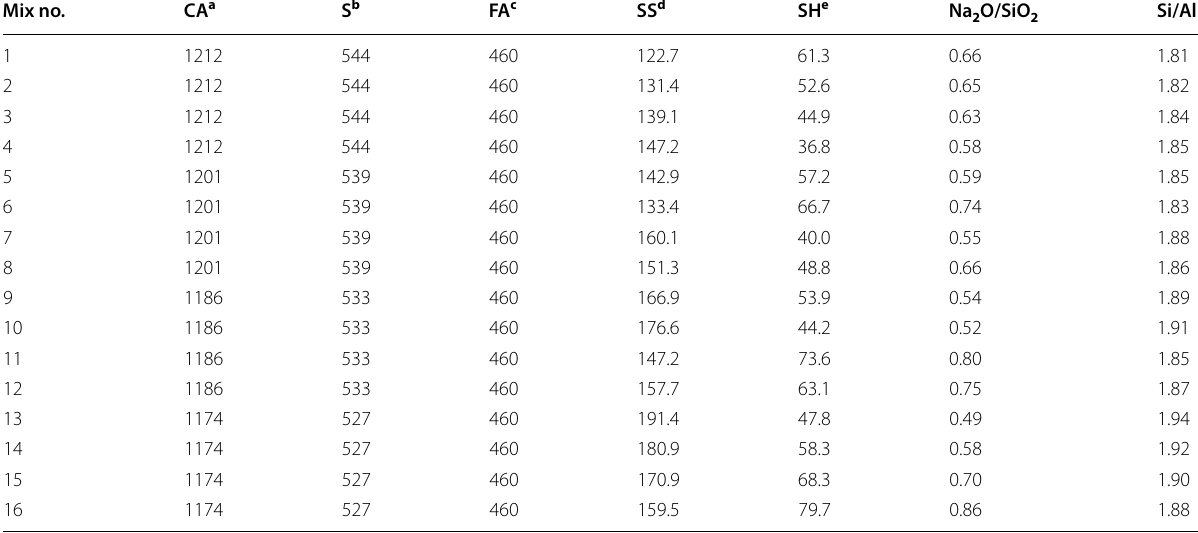
Table 5 Mix proportions of FAGC (kg/m 3 ).